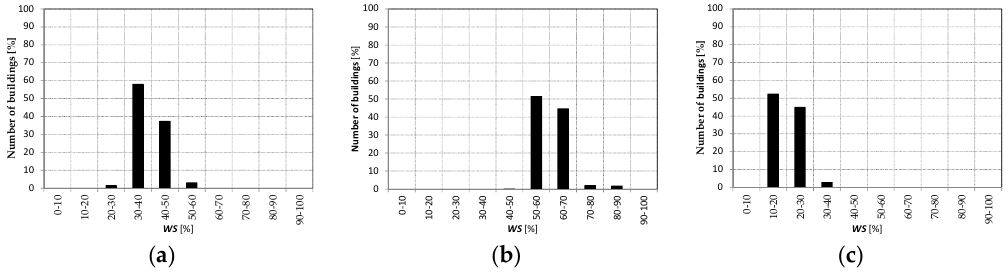
Figure 6. Frequency distribution of optimal tank sizes for r = 3% and for ( a ) N = 15 years; ( b ) N = 25 years.